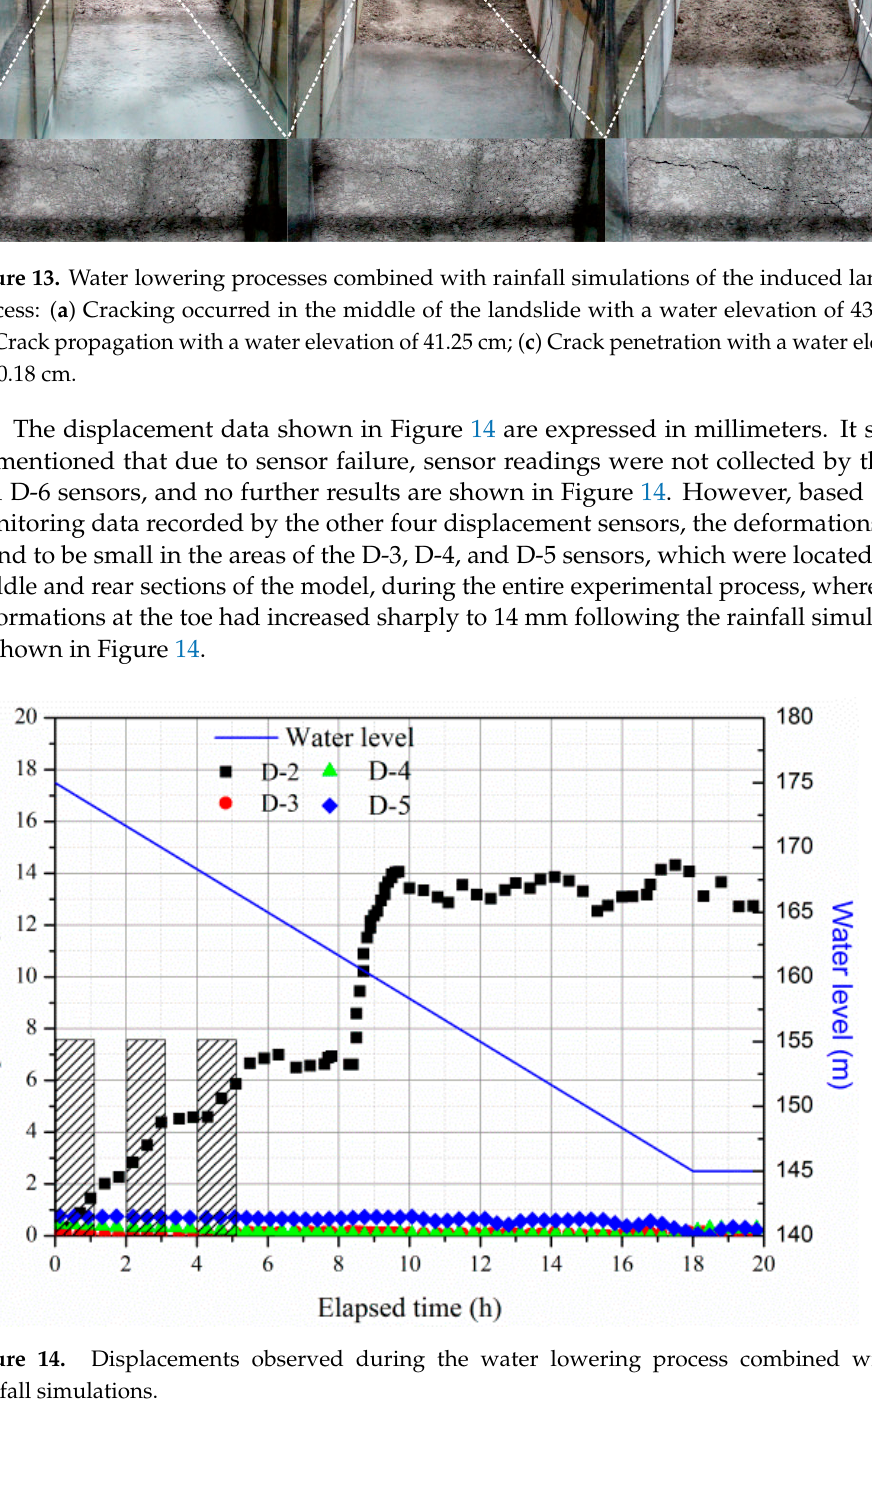
Figure 15. Pore water pressure levels recorded during the water lowering process and rainfall sim- ulations.